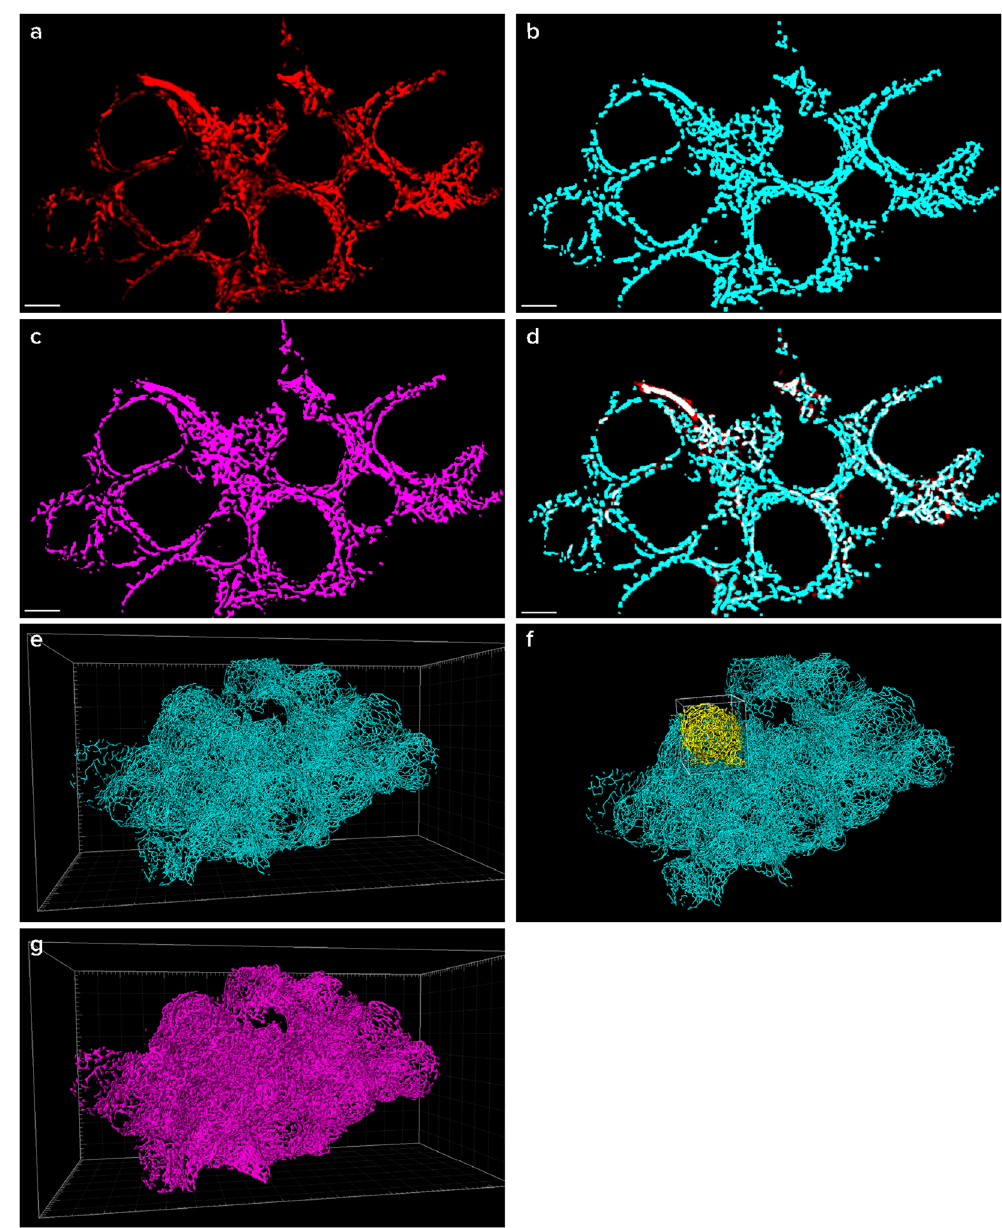
Figure 4. Quantitative analysis of blood vessels in the ovary. A mask was created on the original data of ovarian blood vessels using Ilastik software. From that mask, filaments were calculated using Filament tracing module of Imaris software. A representative slice ( a ), the filament tracing ( b ), the mask created ( c ) and an overlay of the original data with the filaments ( d ) demonstrating high compatibility, are presented (scale bar 300 µ m). A 3D reconstruction of the filaments, a mask of the whole ovary ( e , g ) and a selected single follicle ( f ) are shown. Numerical parameters calculated from the filament analysis are presented in Table